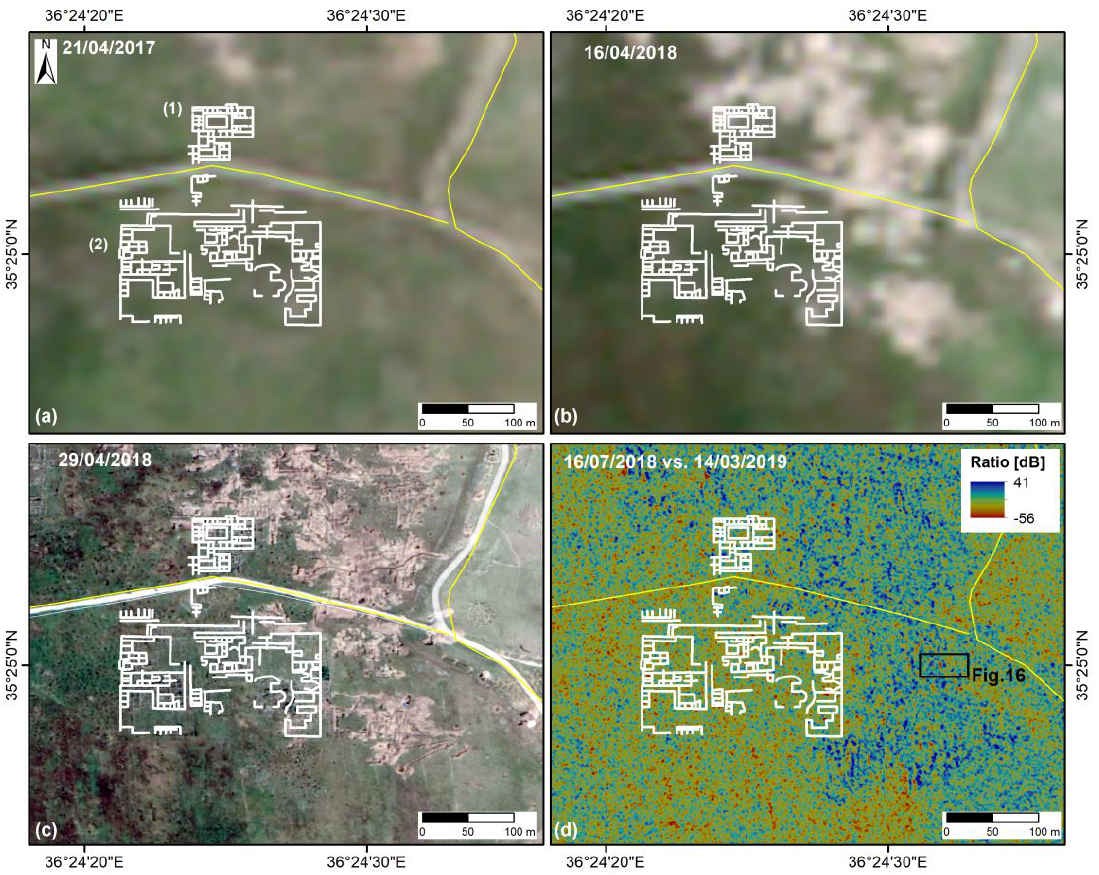
Figure 15. Multi-temporal evolution of looting from April 2017 to March 2019 near the ruins of (1) the House of Consoles and House of the Pilasters and (2) the Eastern Cathedral, along the Decumanus Maximus of Apamea (Syria), as captured in: 10-m resolution Sentinel-2 images acquired on ( a ) 21 / 04 / 2017 and ( b ) 16 / 04 / 2018 (contains Copernicus Sentinel-2 data 2017–2018), ( c ) VHR resolution Google Earth image 29 / 04 / 2018 (Image © 2019 Maxar Technologies), and ( d ) SAR amplitude change detection map from a pair of COSMO-SkyMed Spotlight Enhanced (~1 m ground resolution) scenes acquired in ascending mode on 16 / 07 / 2018 and 14 / 03 / 2019 (COSMO-SkyMed ® Products © ASI—Italian Space Agency—2018–2019. All Rights Reserved).